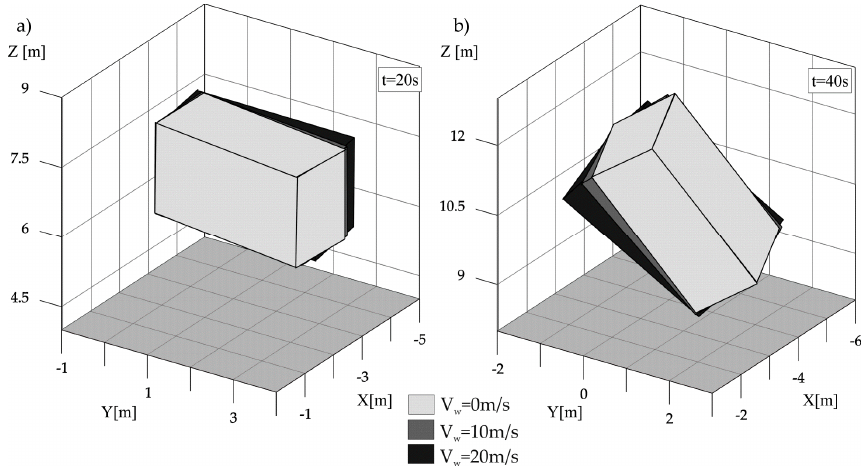
Figure 27. Load orientation in particular moments of time (wind force having impact according to the direction of the Y axis). ( a ) t = 20 s, ( b ) t = 40 s.